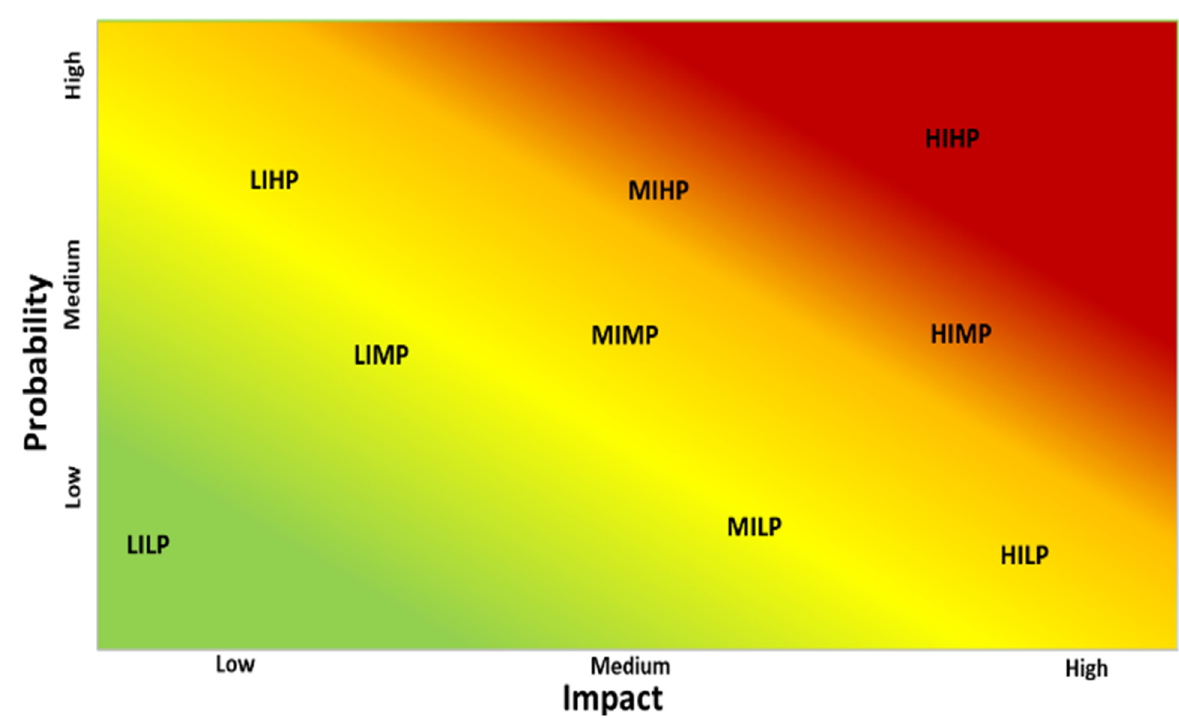
Figure 2. Risk-based contingency case chart.